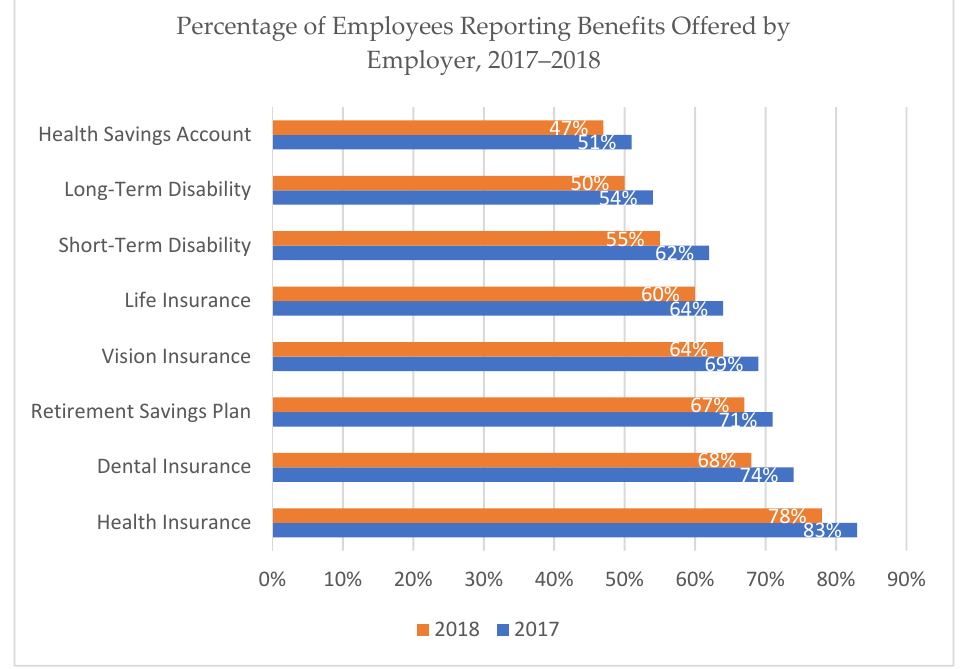
Figure 1. Percentage of Employees Reporting Benefits Offered by Employer, 2017–2018 Source: The State of Employee Benefits: Findings from the 2018 Health and Workplace Benefits Survey,